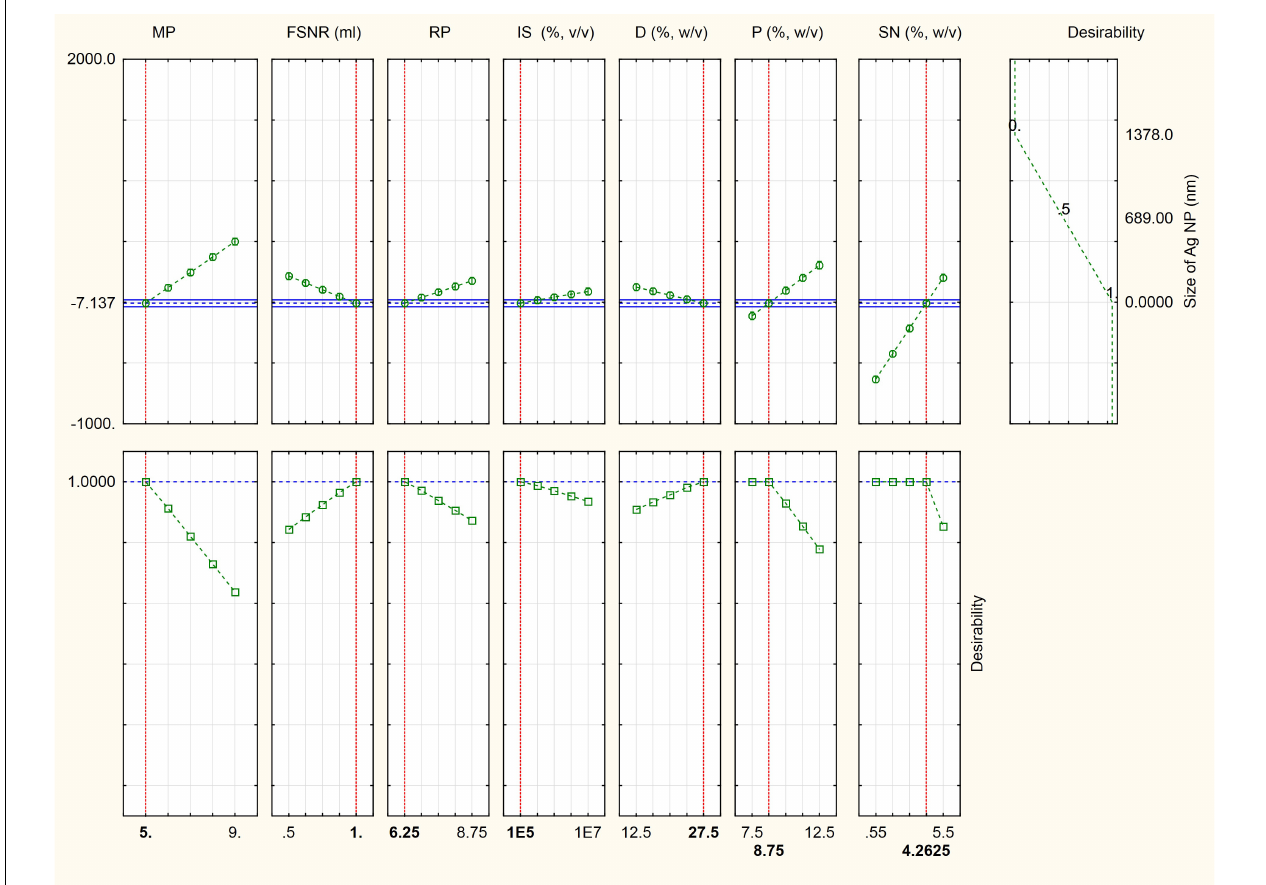
FIGURE 2 | Desirability charts of variables for maximum response. MP, medium pH; FSNR, filtrate to silver nitrate ratio; RP, reaction pH; IS, inoculum size (spores/ml); D, dextrose (g/l); P, peptone (g/l); and SN, silver nitrate (mM).